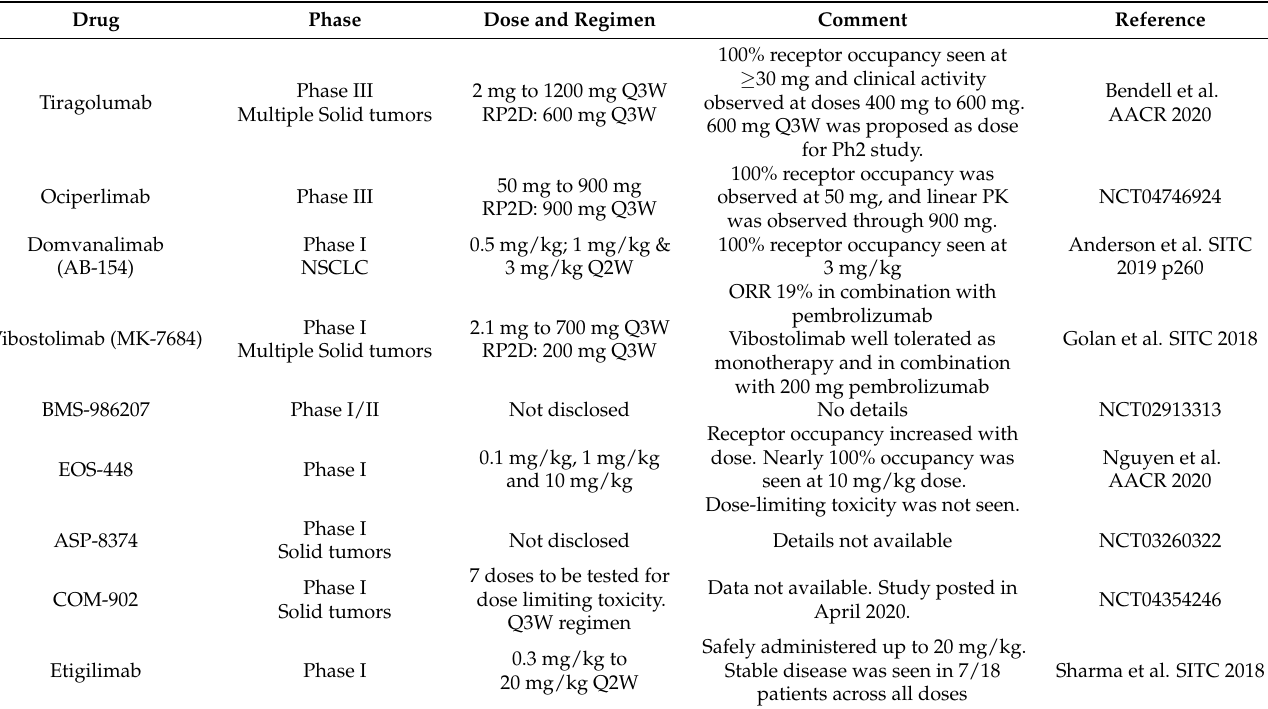
Table 4. Studies reporting anti-TIGIT antibody dose and